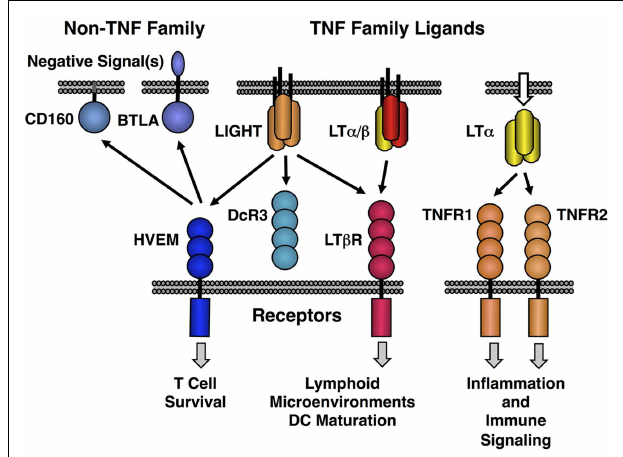
FIGURE 1 | Map of the interactions between LT β R, HVEM, andTNF receptors with the LT/LIGHT family and the Ig-super family members CD160 and BTLA . LIGHT is shown in its membrane bound form, but it is also readily secreted like homotrimeric LT α